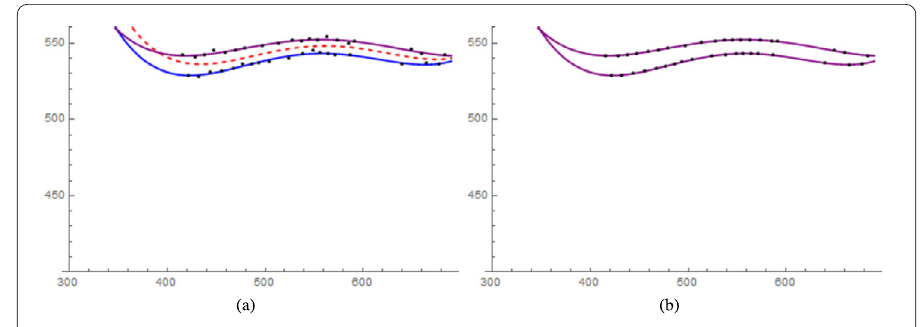
Figure 6 Further polynomial curve fitting. ( a ) Starting points manually marked; ( b ) starting points slightly adjusted to be on the fitted